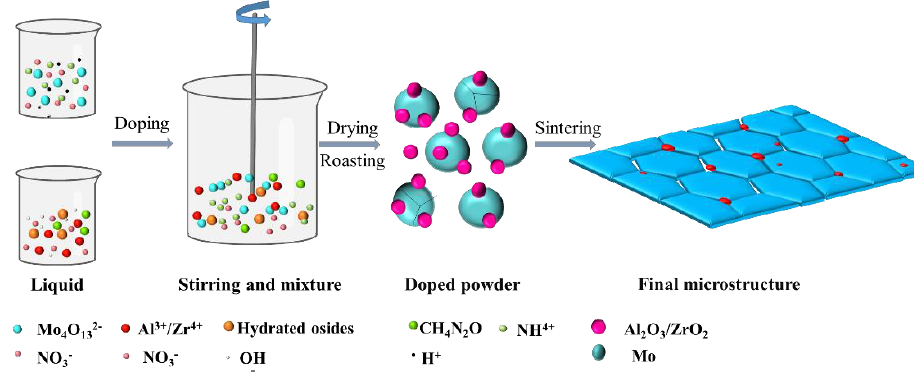
Figure 2. Diagram of liquid − liquid doping process.